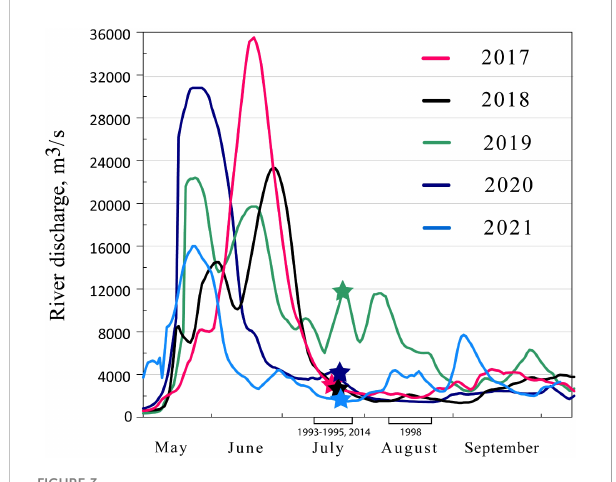
FIGURE 3 Daily variability of the Pechora River discharge during ice-free period in 2017-2021. Periods of surveys in 2017-2021 are indicated by color stars. Periods of surveys in 1993-1995, 1998 and 2014 are indicated by black rectangles on the bottom